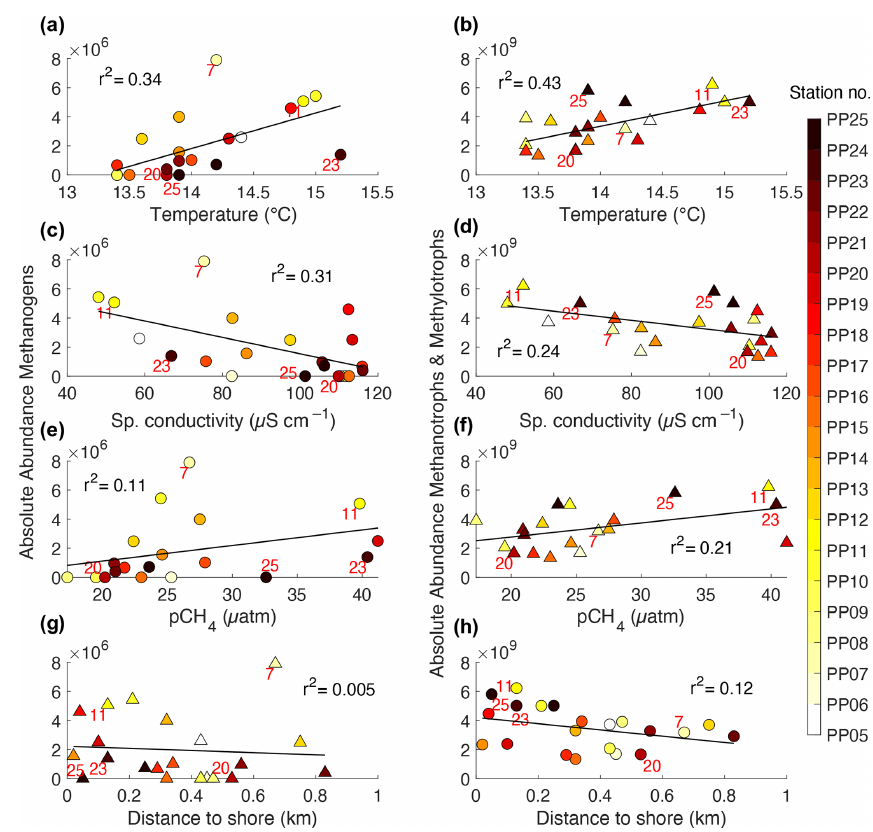
Figure 7. Linear correlations between the total absolute abundances of archaeal microbial communities (a, c, e, and g , methanogens and b, d, f, and h , methanotrophs and methylotrophs ) and the 1min averages of water properties measured at the 21 sampling stations along the UP transect in the Kolyma River. Red numbers in some of the markers indicate the station number corresponding to the key sites S1 to S5.